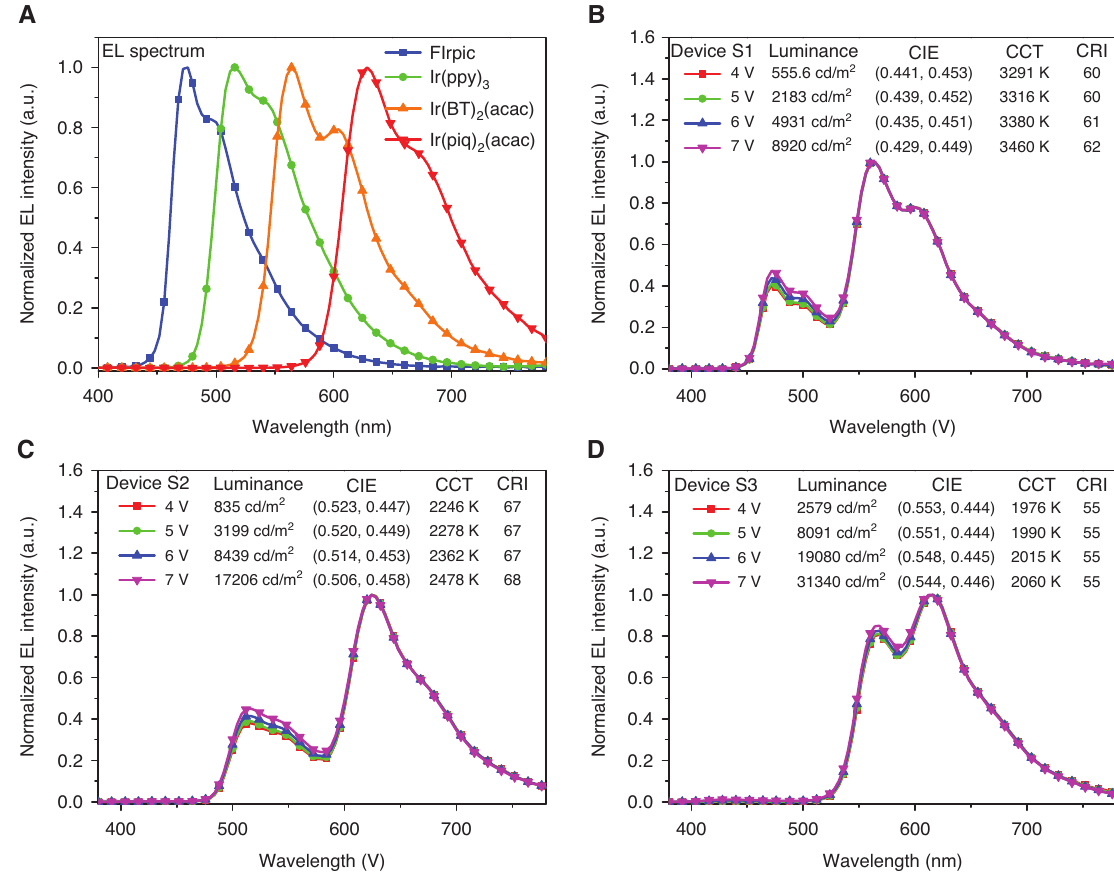
, Ir(BT) (acac), and Ir(piq) (acac) based monochrome OLEDs; (B–D) The EL spectra of all single 3 2 2